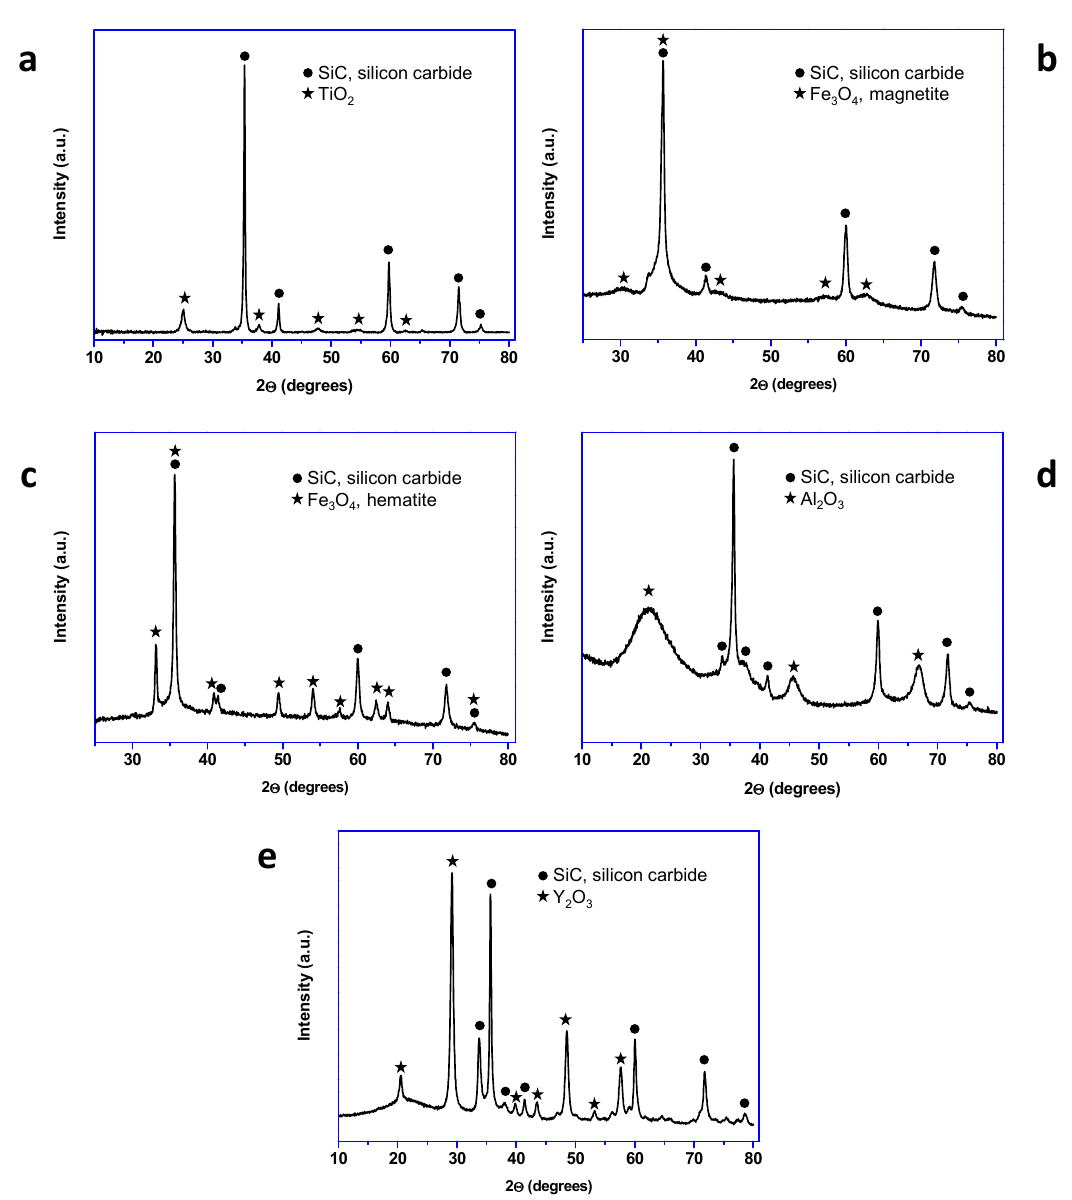
Figure 2. X-ray diffraction patterns of the synthetized core–shell nanomaterials (lab synthesis): ( a ) TiO 2 @SiC; ( b ) Fe 3 O 4 @SiC; ( c ) Fe 2 O 3 @SiC; ( d ) Al 2 O 3 @SiC; and ( e ) Y 2 O 3 @SiC.